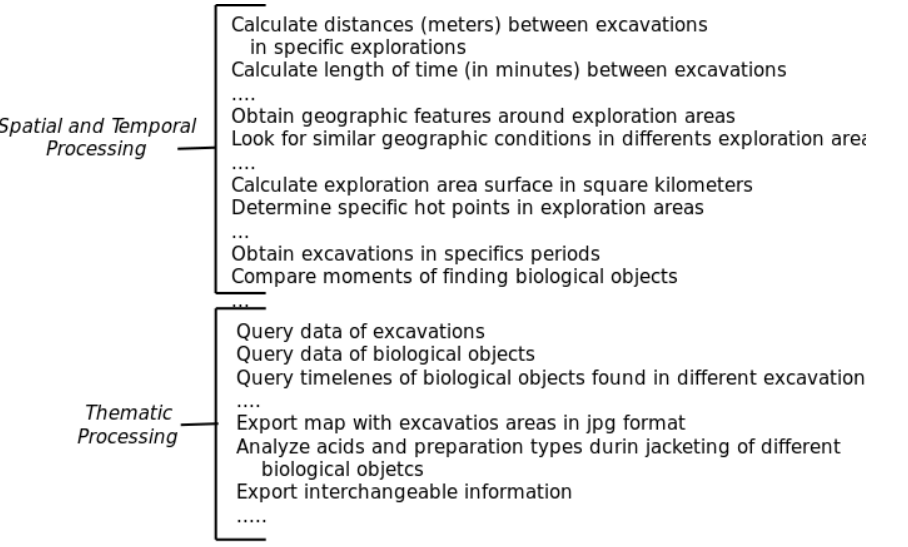
Figure 9. Services representing spatial and thematic processing of paleontological